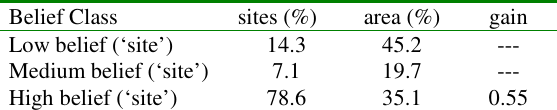
Table 1. Performance of the predictive model